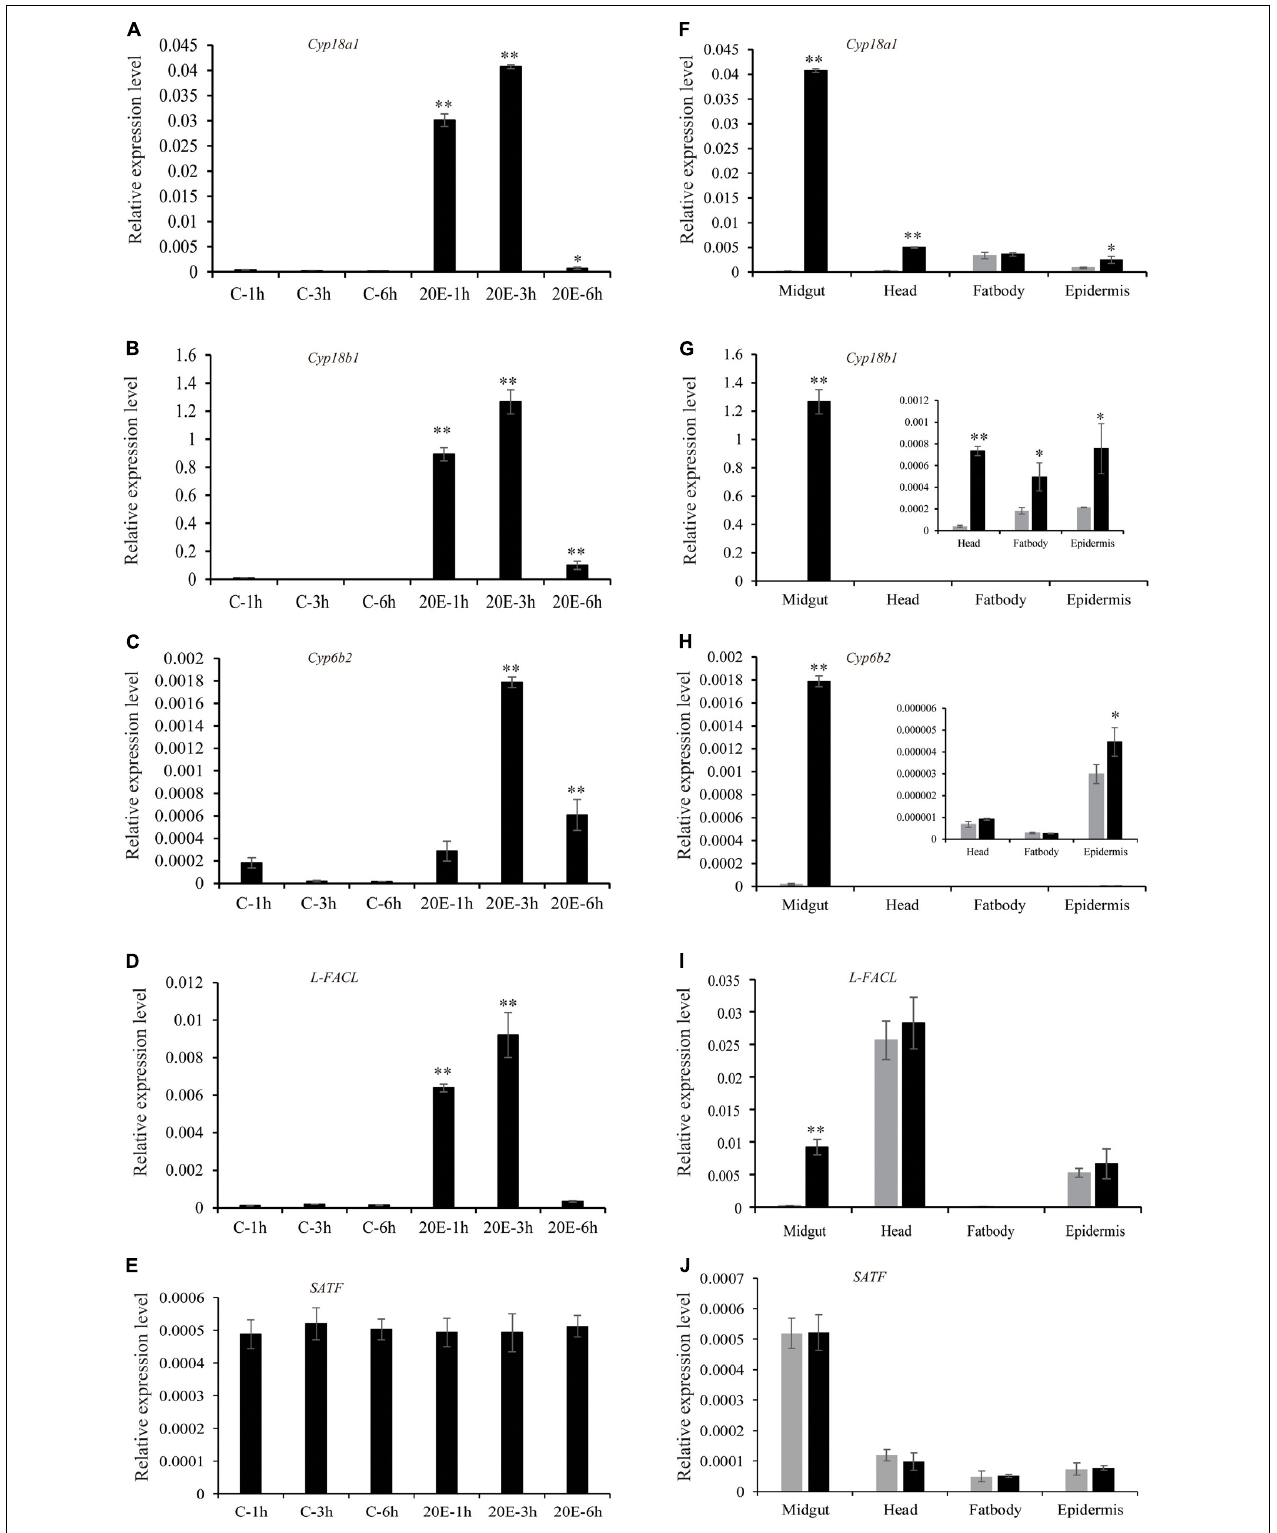
FIGURE 4 | Expression pattern of the candidate genes after 20E treatment. (A–E) The expression of the candidate genes in cotton bollworm larvae midgut at different time points after control or 20E treatment. (F–J) The expression of the candidate genes in different tissues at 3 h after control or 20E treatment. * p value via student’s t -test based on three replicates (* p < 0.05; ** p < 0.01).